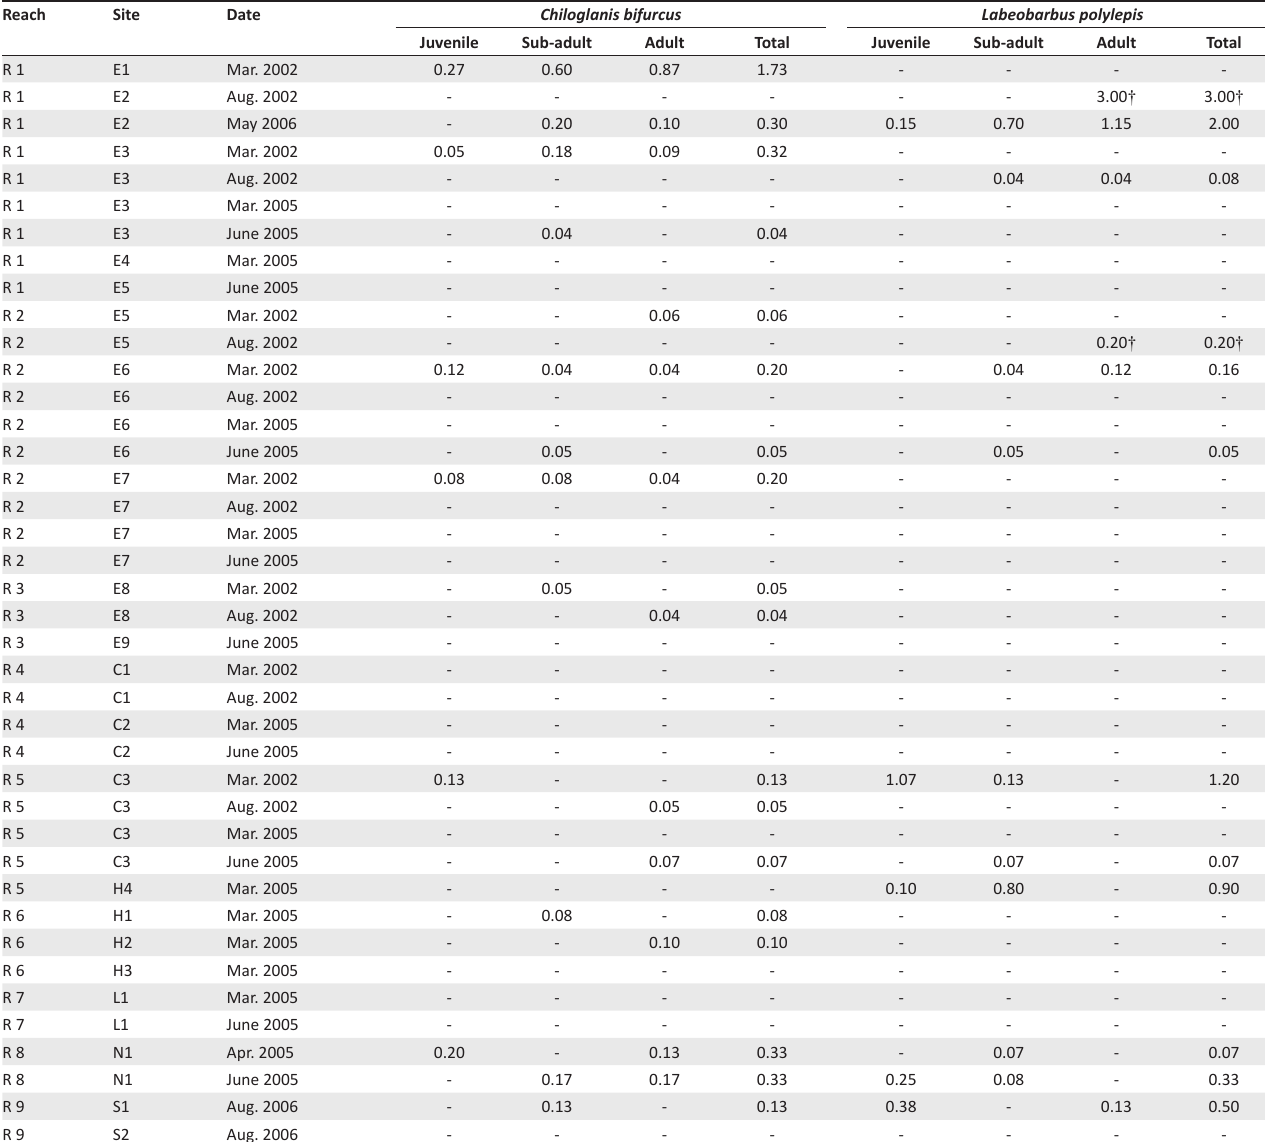
TABLE 1: Catch per unit effort of the juveniles, sub-adult and adult Chiloglanis bifurcus and Labeobarbus polylepis collected using electrofishing and gill net sampling techniques during fish community structure assessments of the study from 2002 to 2006.